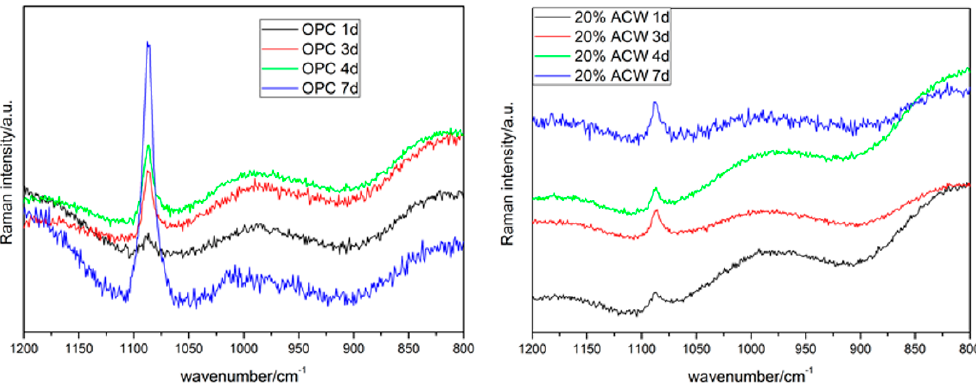
Figure 10. Raman spectra by exposure time for OPC ( left ) and 20% ACW ( right ) pastes.